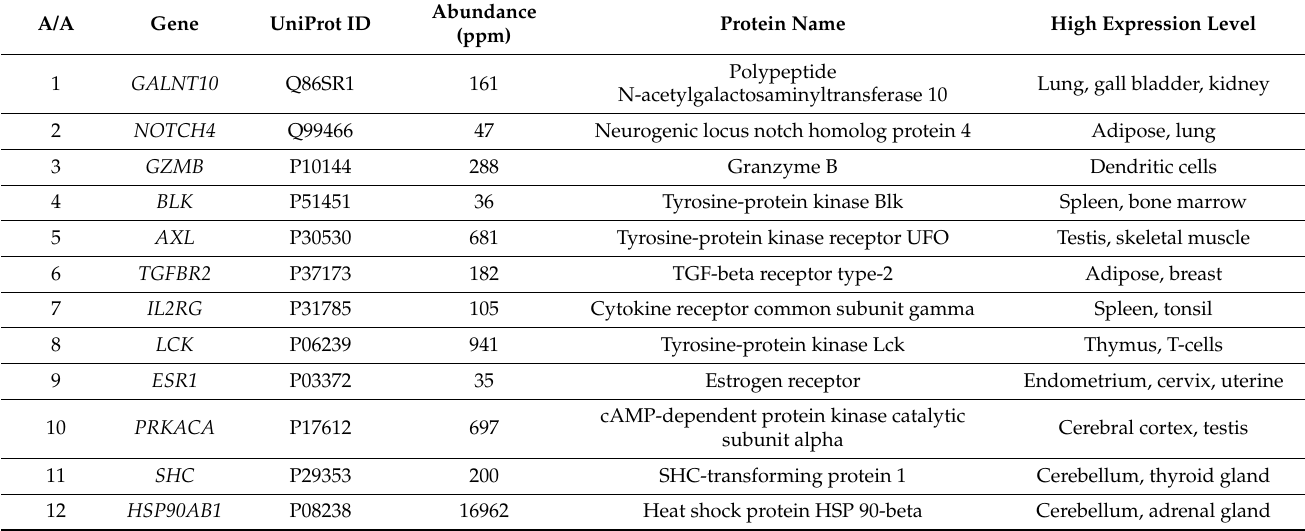
Table 1. Names, UniProt IDs, abundances, and tissue-specific expressions of Cd-binding pro- teins, annotated as genetic markers in 12 cancer types. Abundances and tissue-specific expressions were mined according to the protein abundance database PaxDB (https://pax-db.org (accessed on 21 October 2022)) and human proteome atlas database (https://www.proteinatlas.org (accessed on 21 October